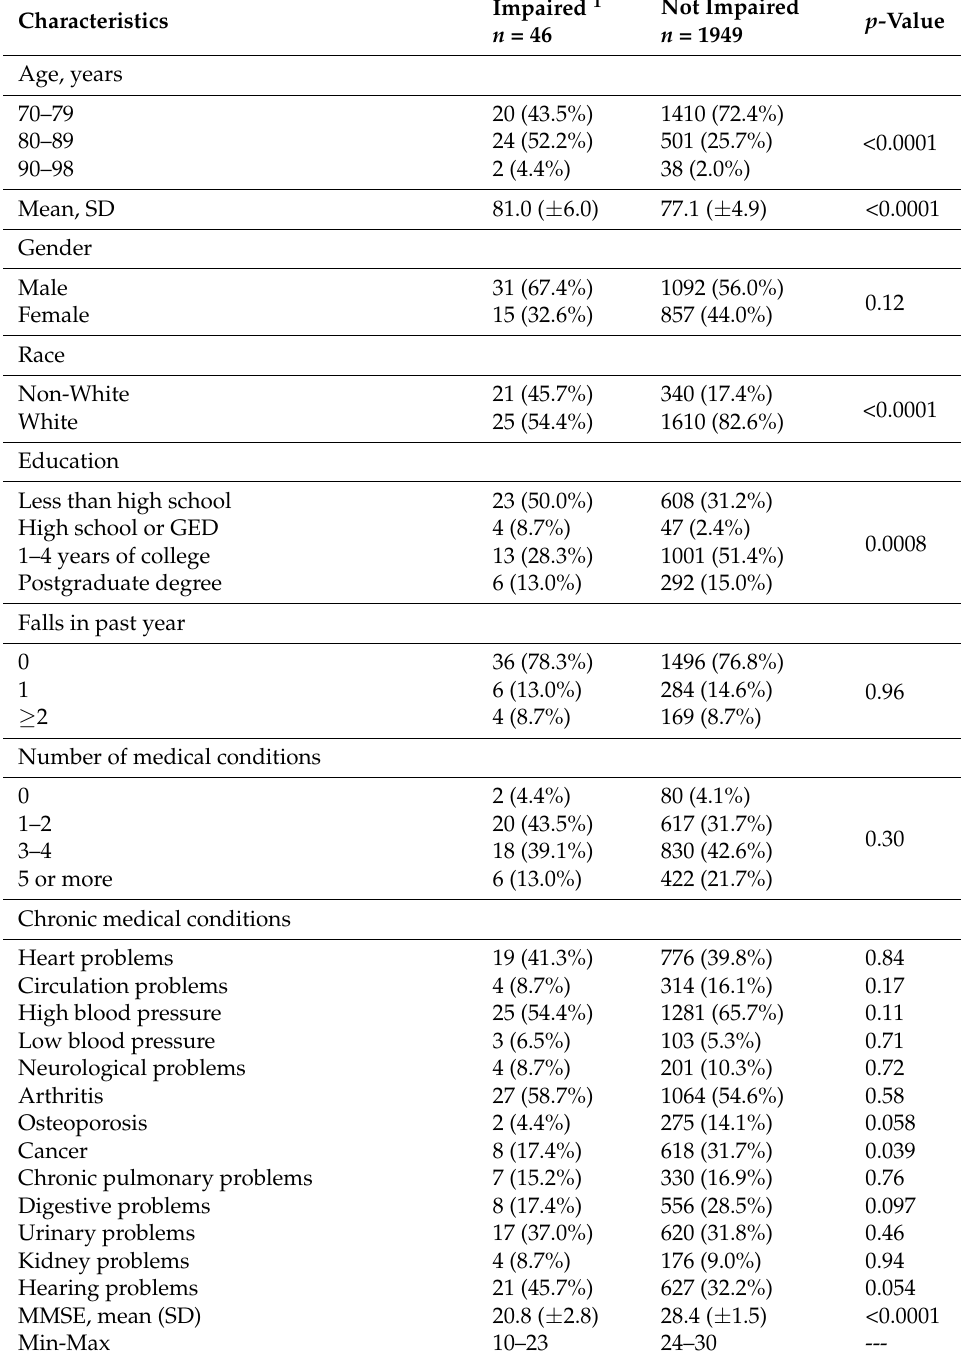
Table 1. Demographic, visual, medical, and driving characteristics by mental status (Mini Mental State Exam (MMSE)) at baseline ( N =